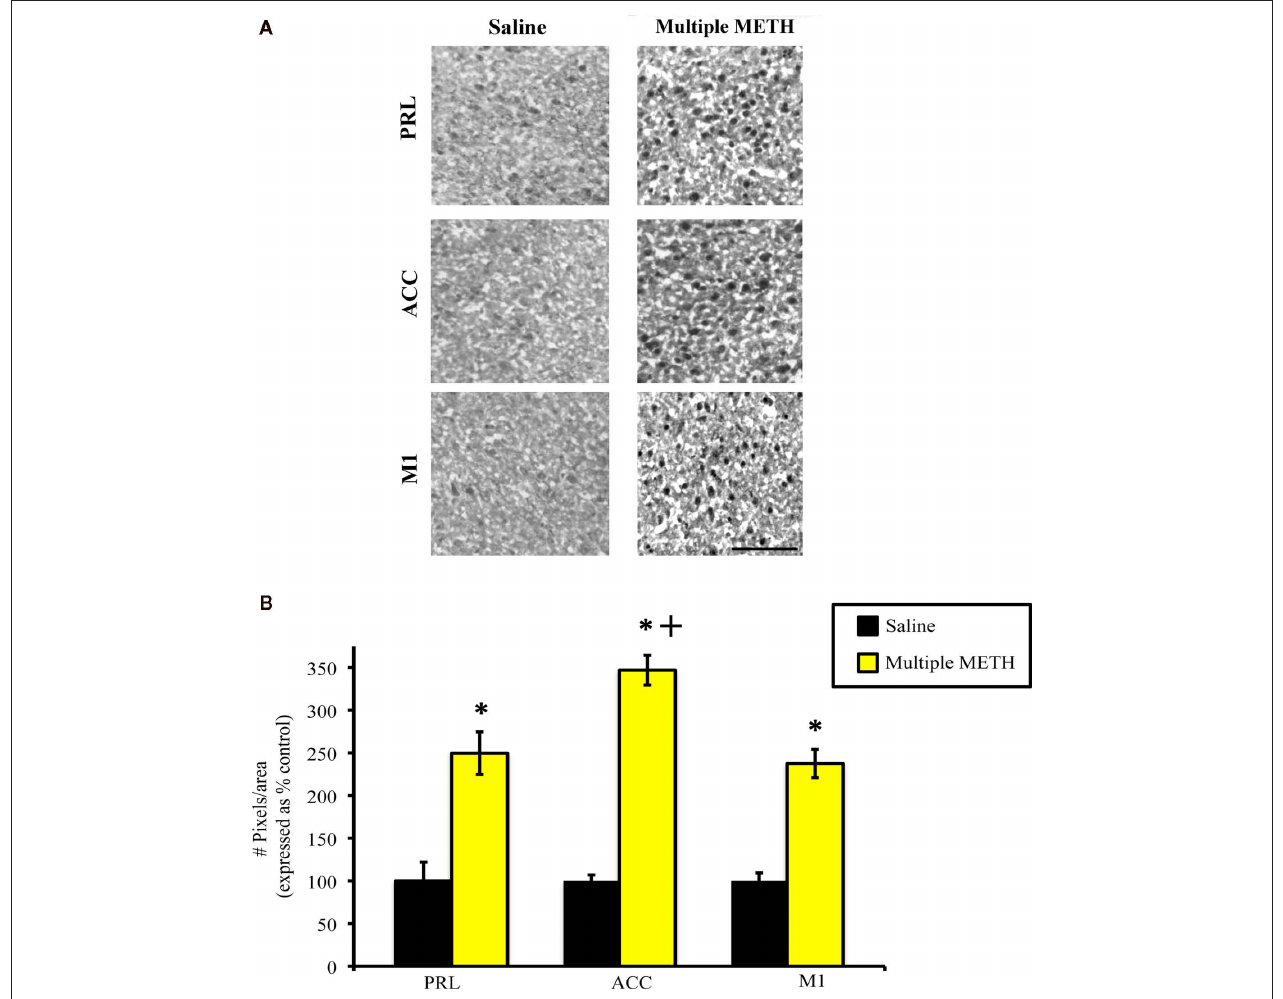
significantly increased MDA-ir in all three regions of cortex examined (B) . Multiple METH treatment also resulted in significantly greater MDA-ir in the ACC sub-region of cortex, as compared to the PRL and M1 cortical sub-regions. * p < 0.05 as compared to saline-treated animals; + p < 0.05 as compared to the PRL and M1 sub-regions of cortex in